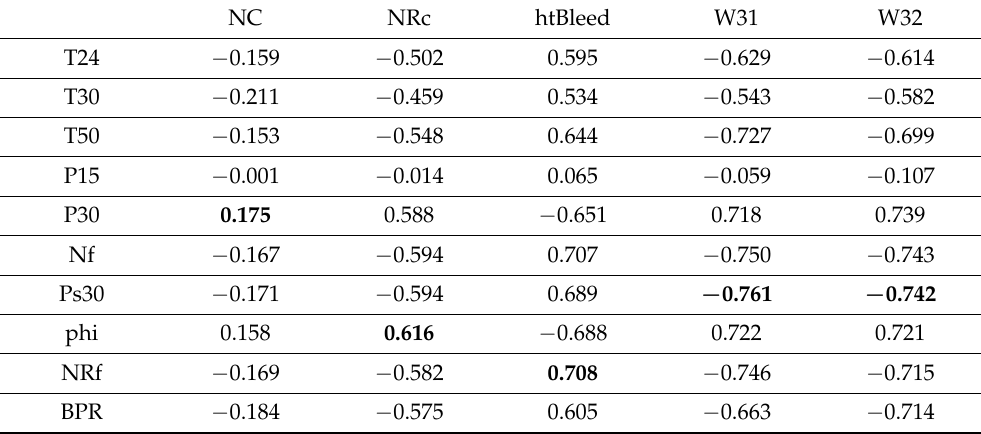
Table 2. Correlation matrix. The bold cell shows the maximum correlation